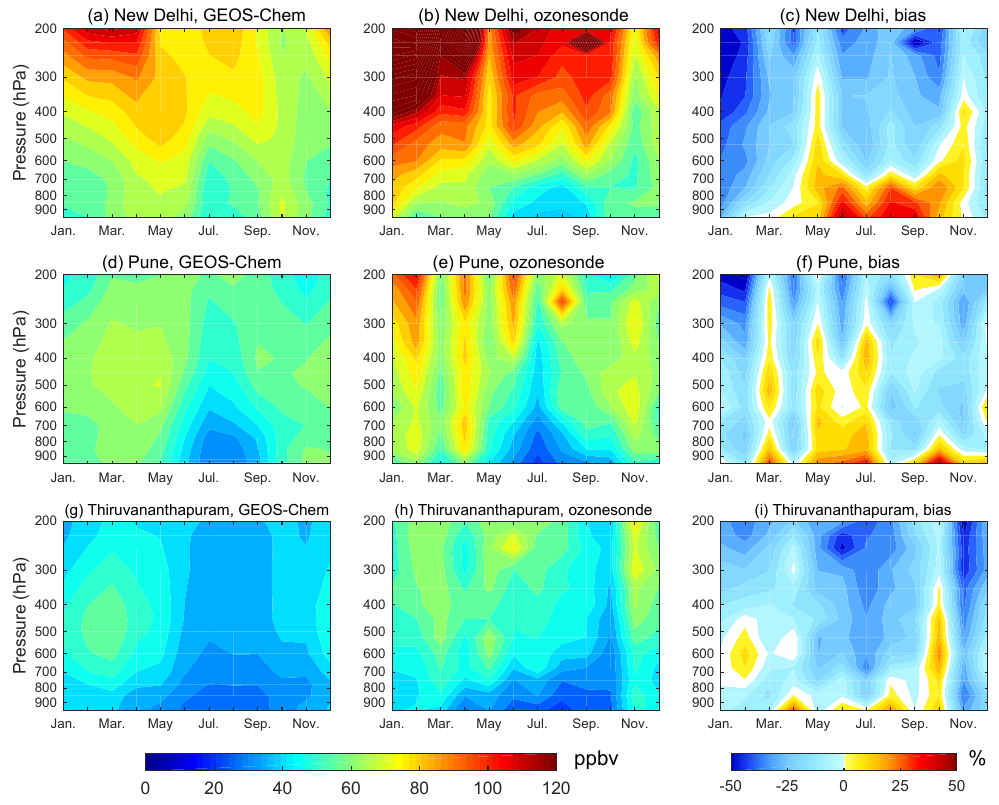
Figure 4. Seasonal variation of vertical ozone profiles from the GEOS-Chem simulations (in ppbv, a, d, g ), ozonesonde measurements (in ppbv, b, e, h ), and the corresponding bias (in %, c, f, i ) averaged over 1994–2003 at three Indian sites, New Delhi (a–c) , Pune (d–f) , and Thiruvananthapuram (g–i)